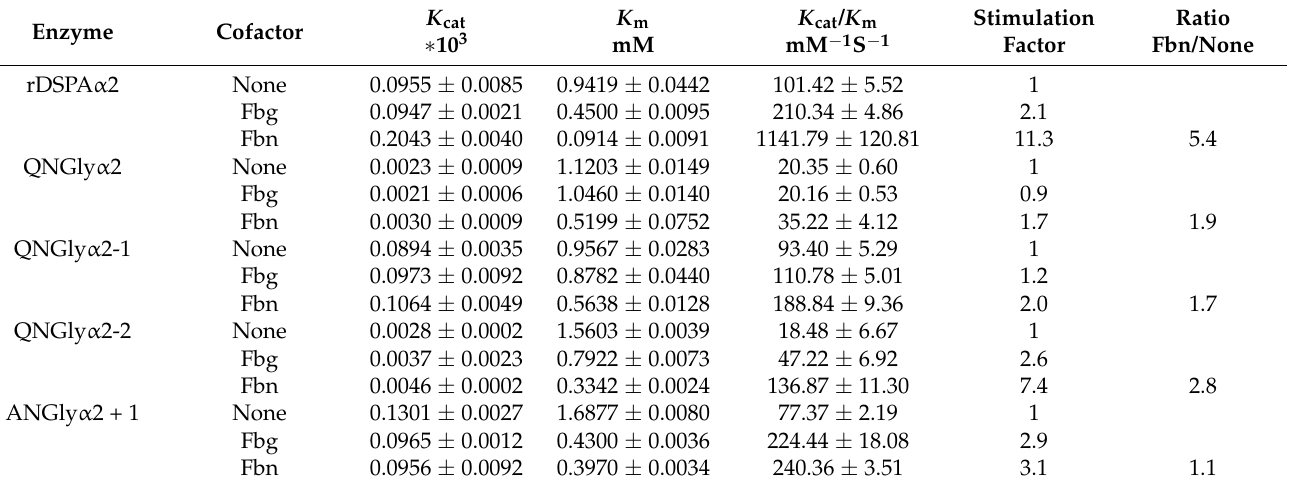
Table 2. The kinetic parameters of the S-2765 hydrolysis by the DSPAs and t-PA in the presence or absence of a fibrin/fibrinogen